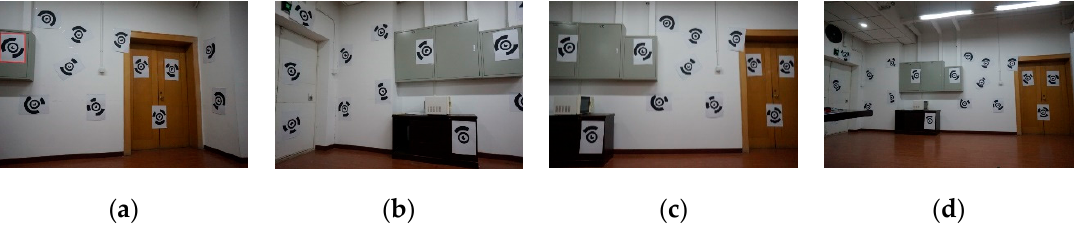
Figure 9. Experiment images. ( a – d ) show the images from group 1 to group 4.